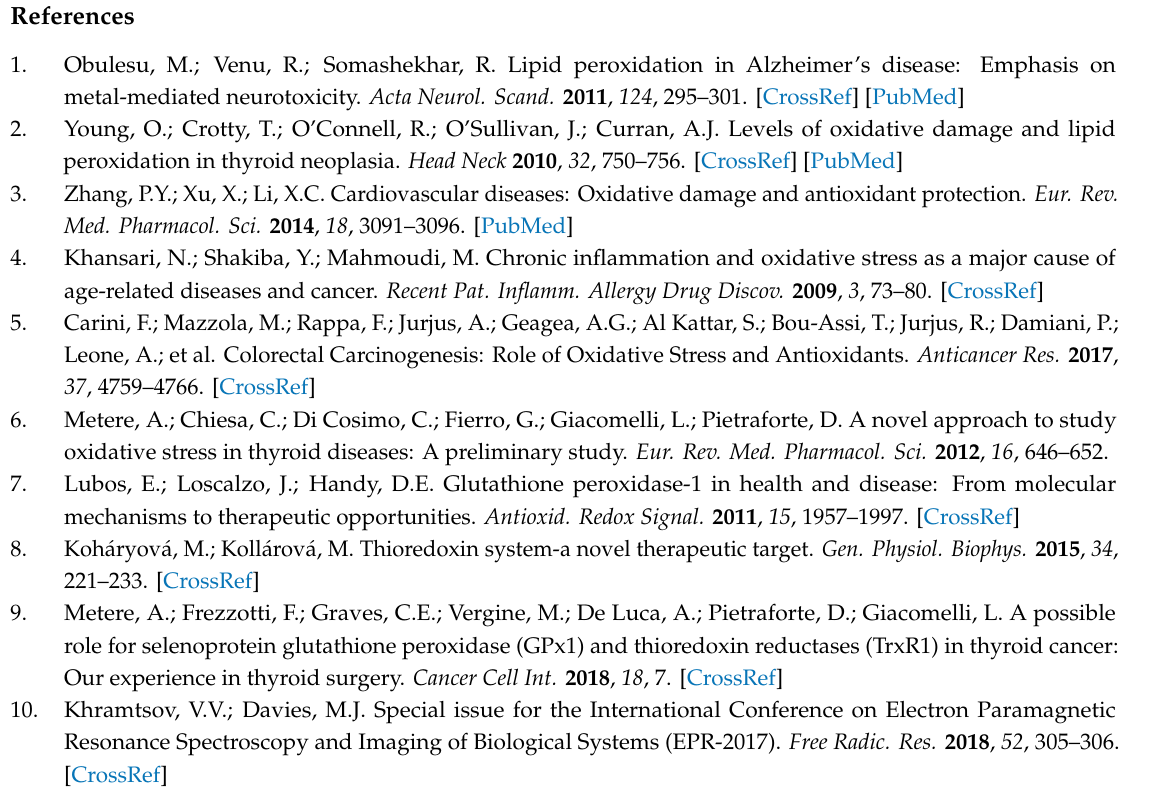
Figure S1: The variable importance in projection (VIP) for the analyzed metabolites in the PLS-DA model, Table S1: Absolute and relative quantification of metabolites detected by NMR in thyroid cancer and healthy thyroid